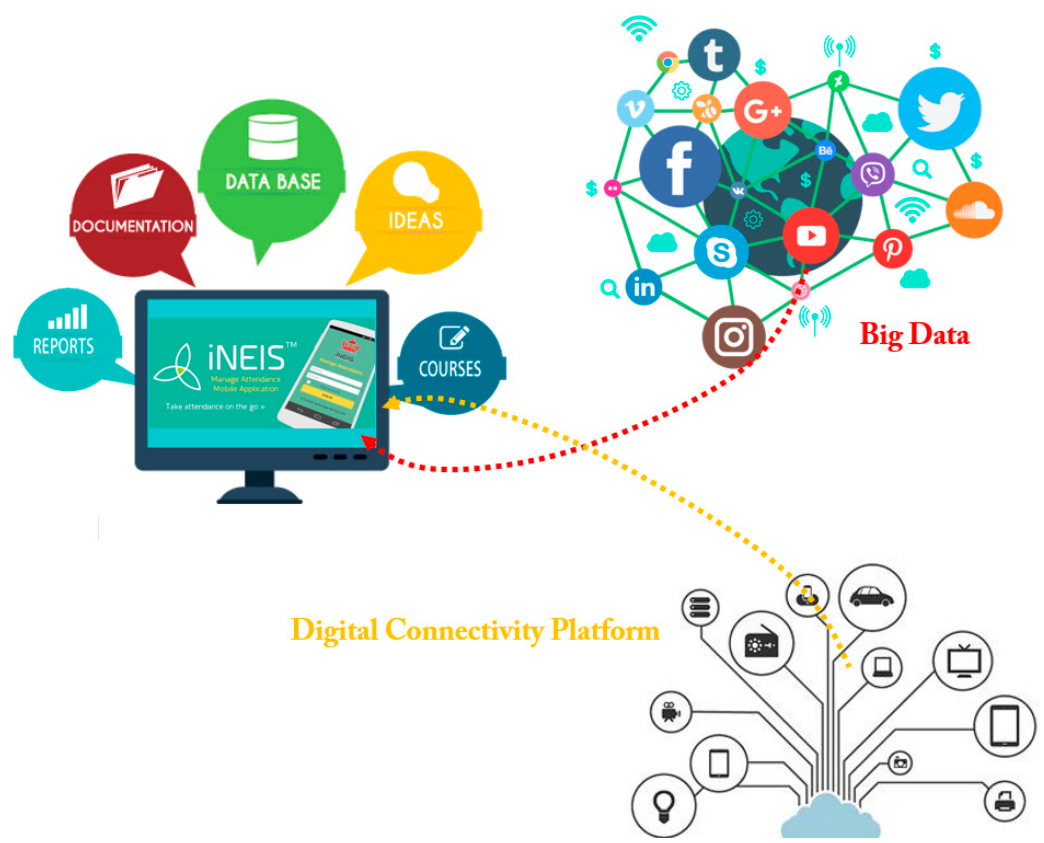
Figure 4. E-iNEIS TM big data and digital connectivity.